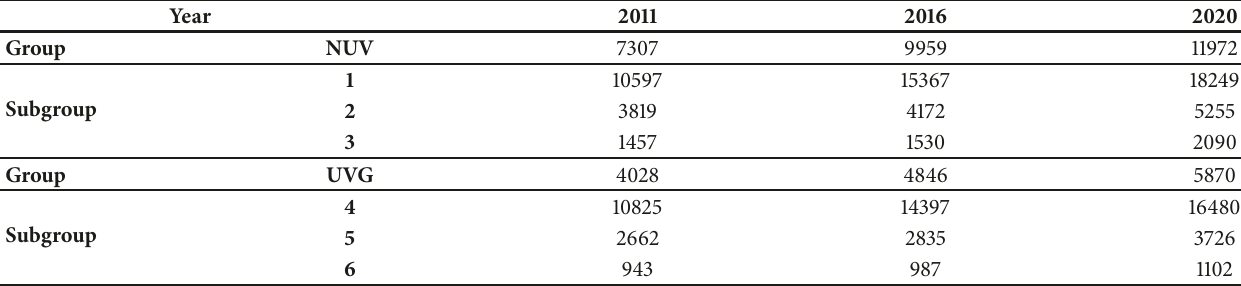
Table 4: The average transit opportunity of two groups in the whole city.